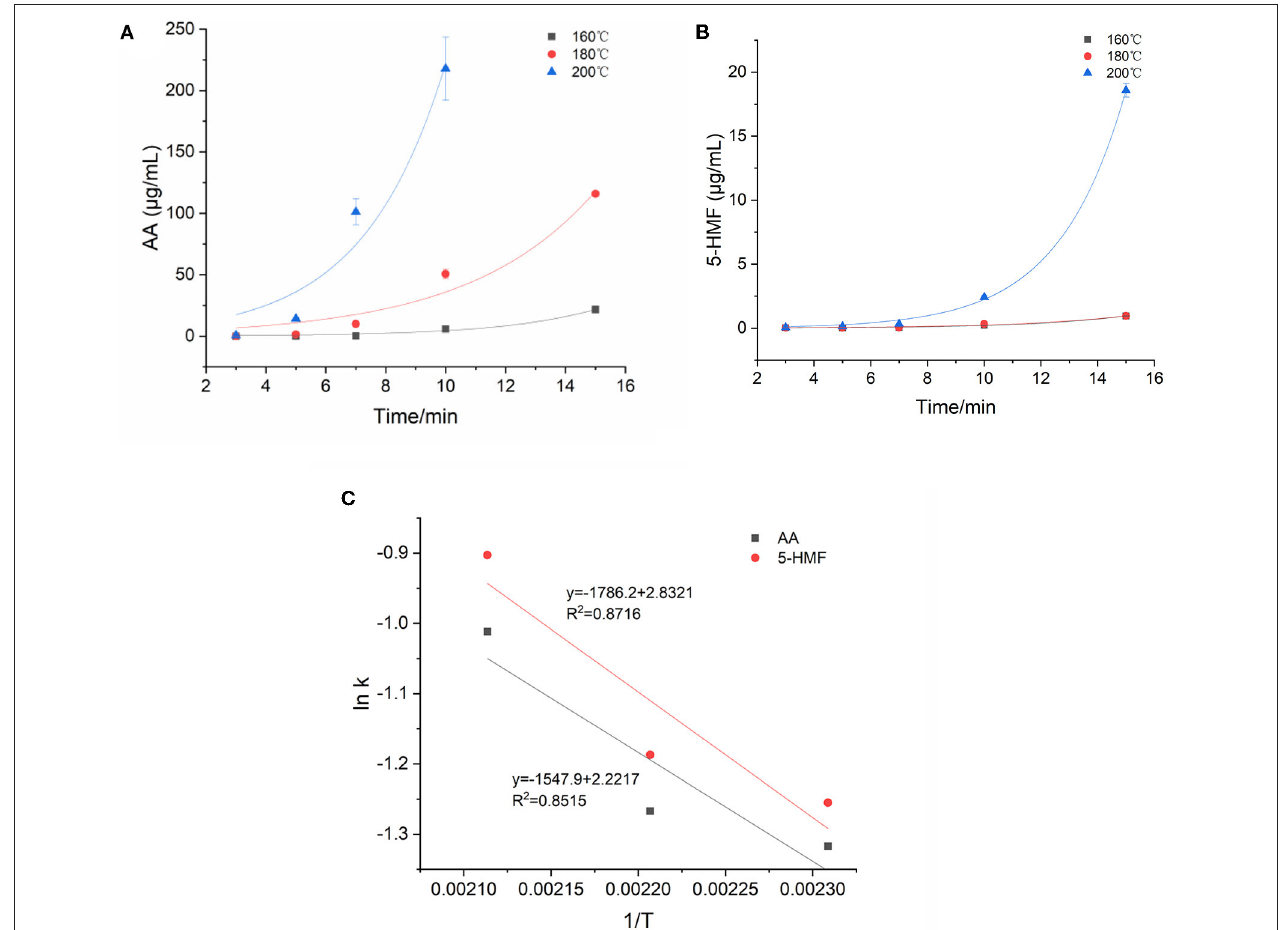
FIGURE 3 | Kinetic changes of AA and 5-HMF in heated model system (A) AA, (B) 5-HMF, and (C) Arrhenius plot.